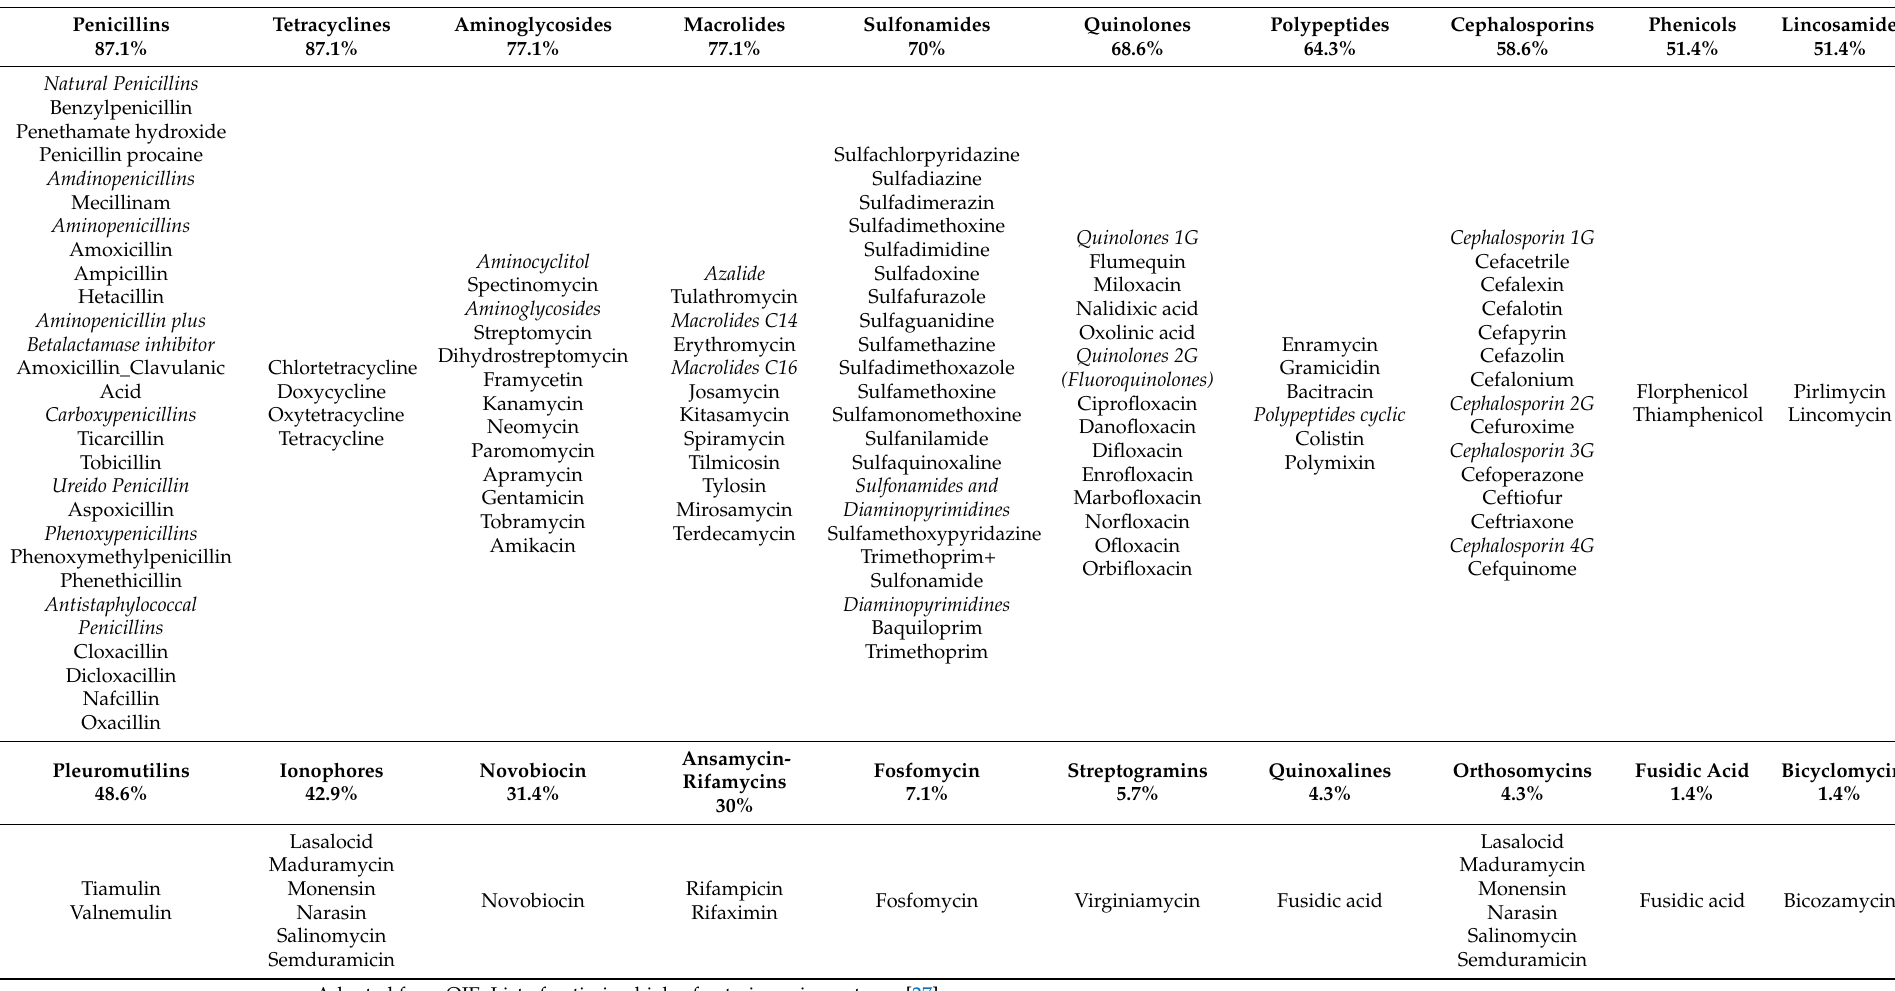
Adapted from OIE, List of antimicrobials of veterinary importance